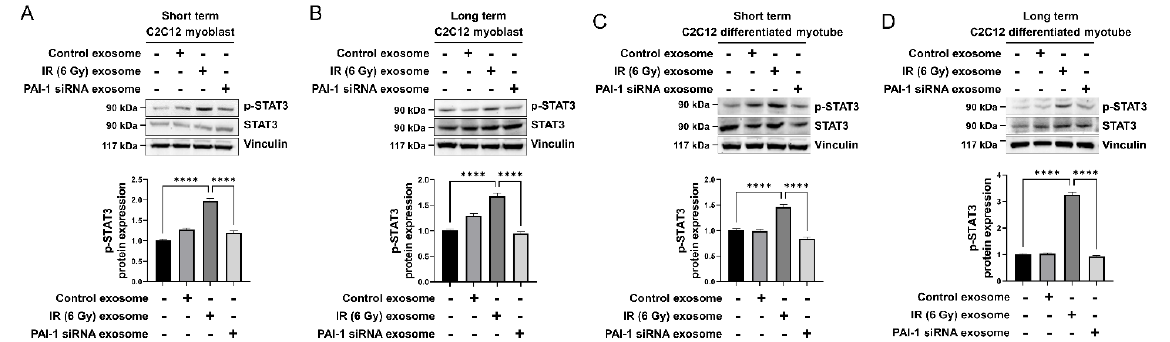
Figure 6. Exosomal PAI-1 activated intracellular STAT3 in differentiated myotubes. ( A – D ) The protein expression of phosphorylated STAT3 was assessed by western blot in C2C12 myoblast cell, C2C12 differentiated myotube cell treated with U87MG exosome in the short-term or long-term (upper panel). p-STAT3 level was quantified (lower panel). Statistical analysis was performed with one-way ANOVA plus Tukey’s multiple comparisons test. **** p < 0.0001.